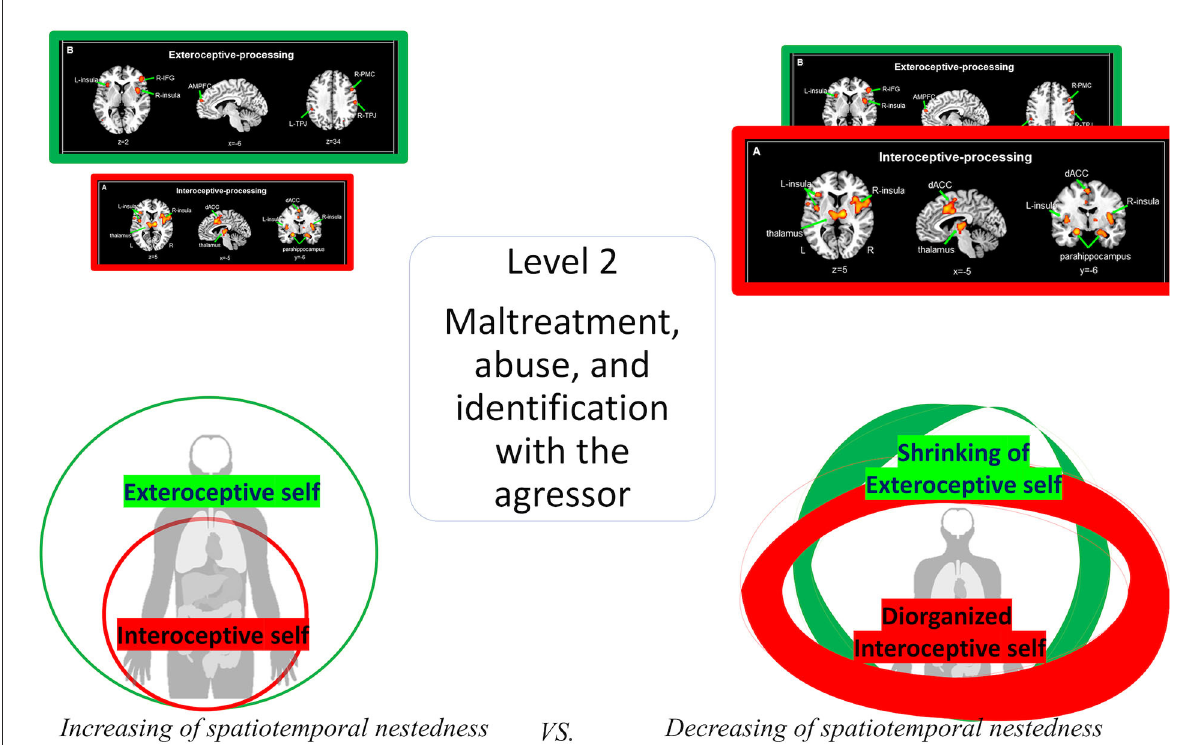
FIGURE7 Visual representation of the shrinking of proprio-exteroceptive self